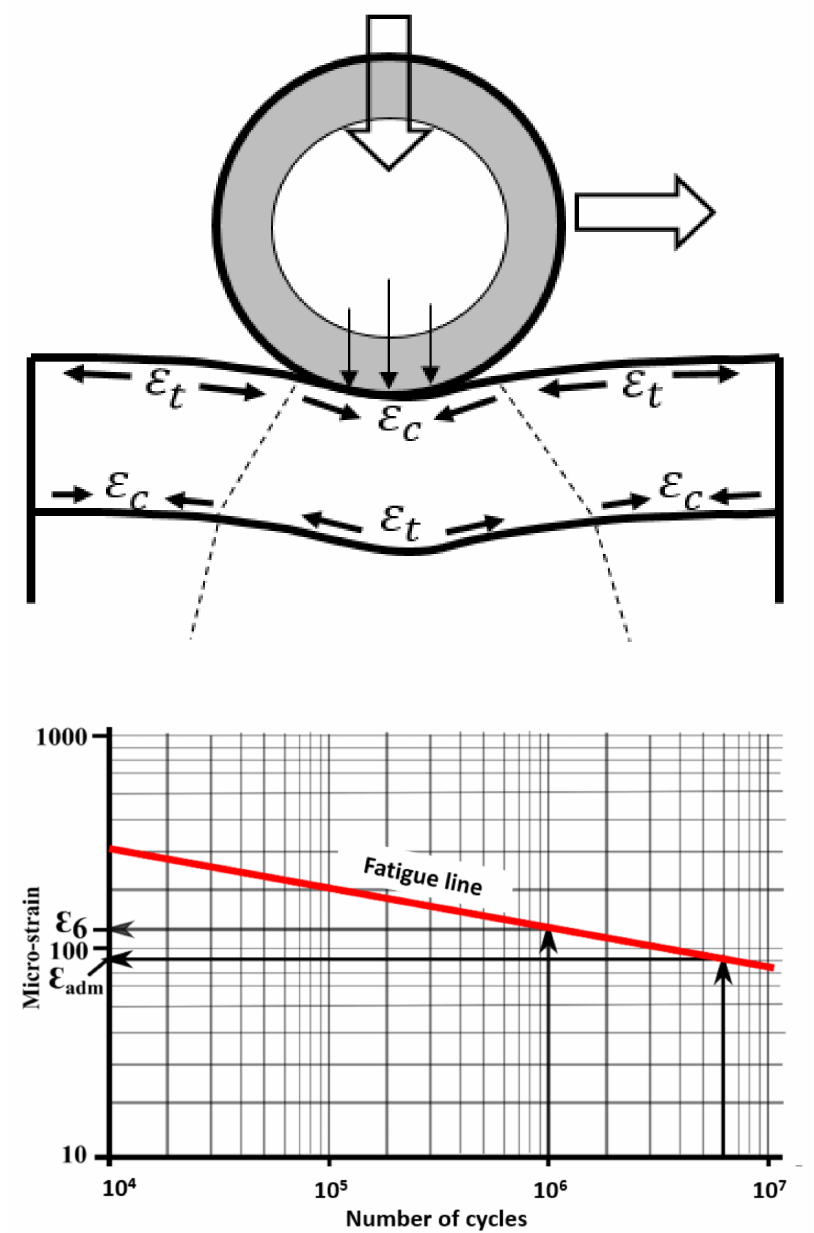
Figure 7. Strains present in the layers of the pavement under loading and fatigue line of bituminous mixes